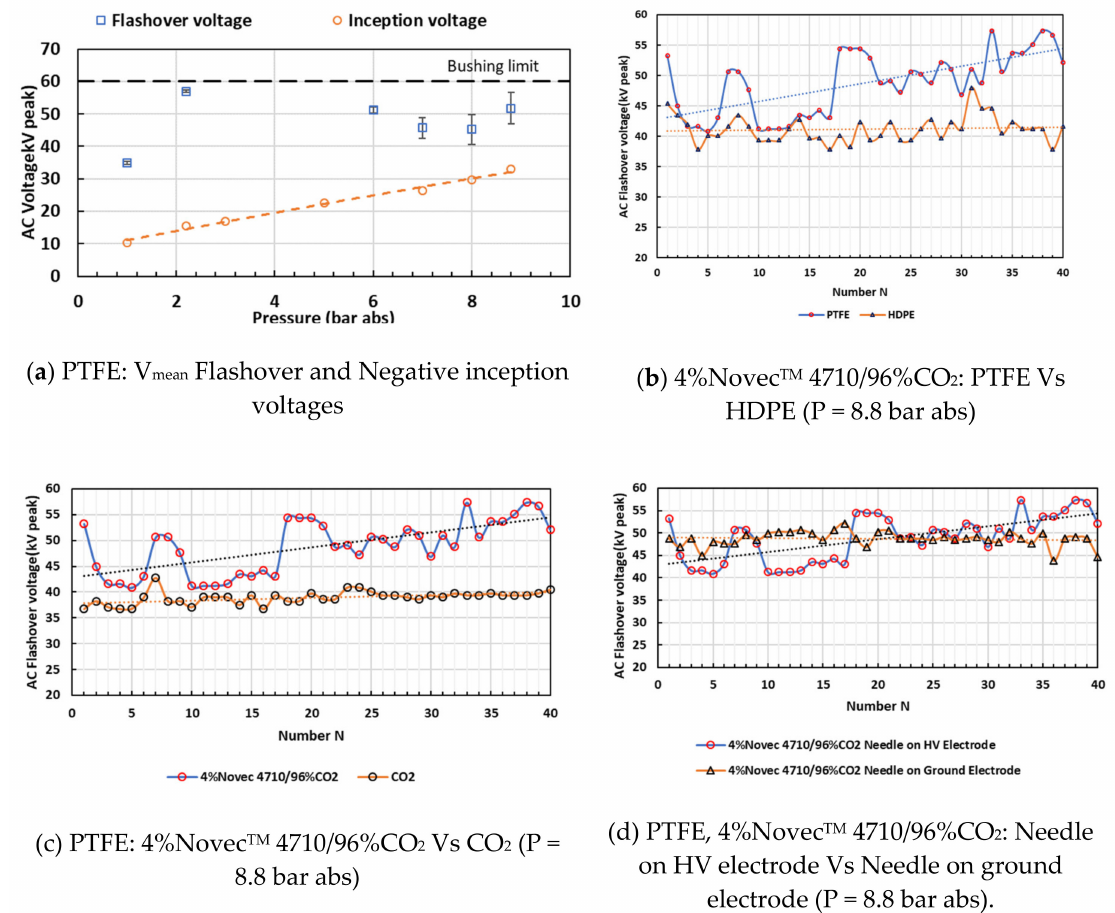
Figure 14. Flashover voltage of the insulator defect (4%Novec TM 4710 / 96%CO 2 , PTFE, Needle on HV